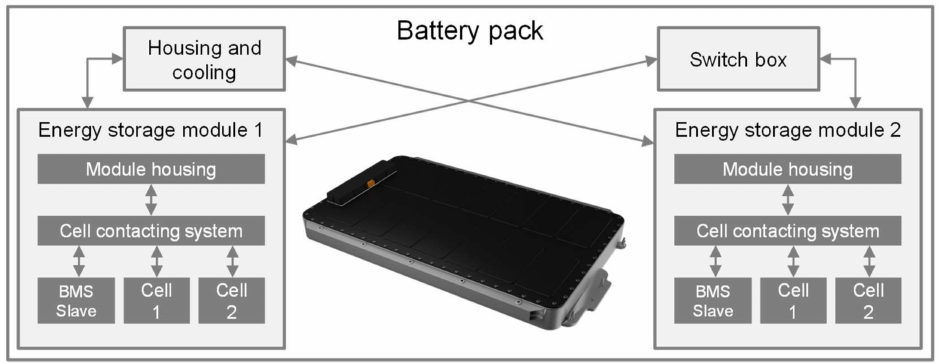
Figure 2. Schematic representation of the basic structure of the state-of-the-art electric vehicle battery packs with modular product architecture [7]. The arrows represent the physical connections between the individual components that have to be separated during